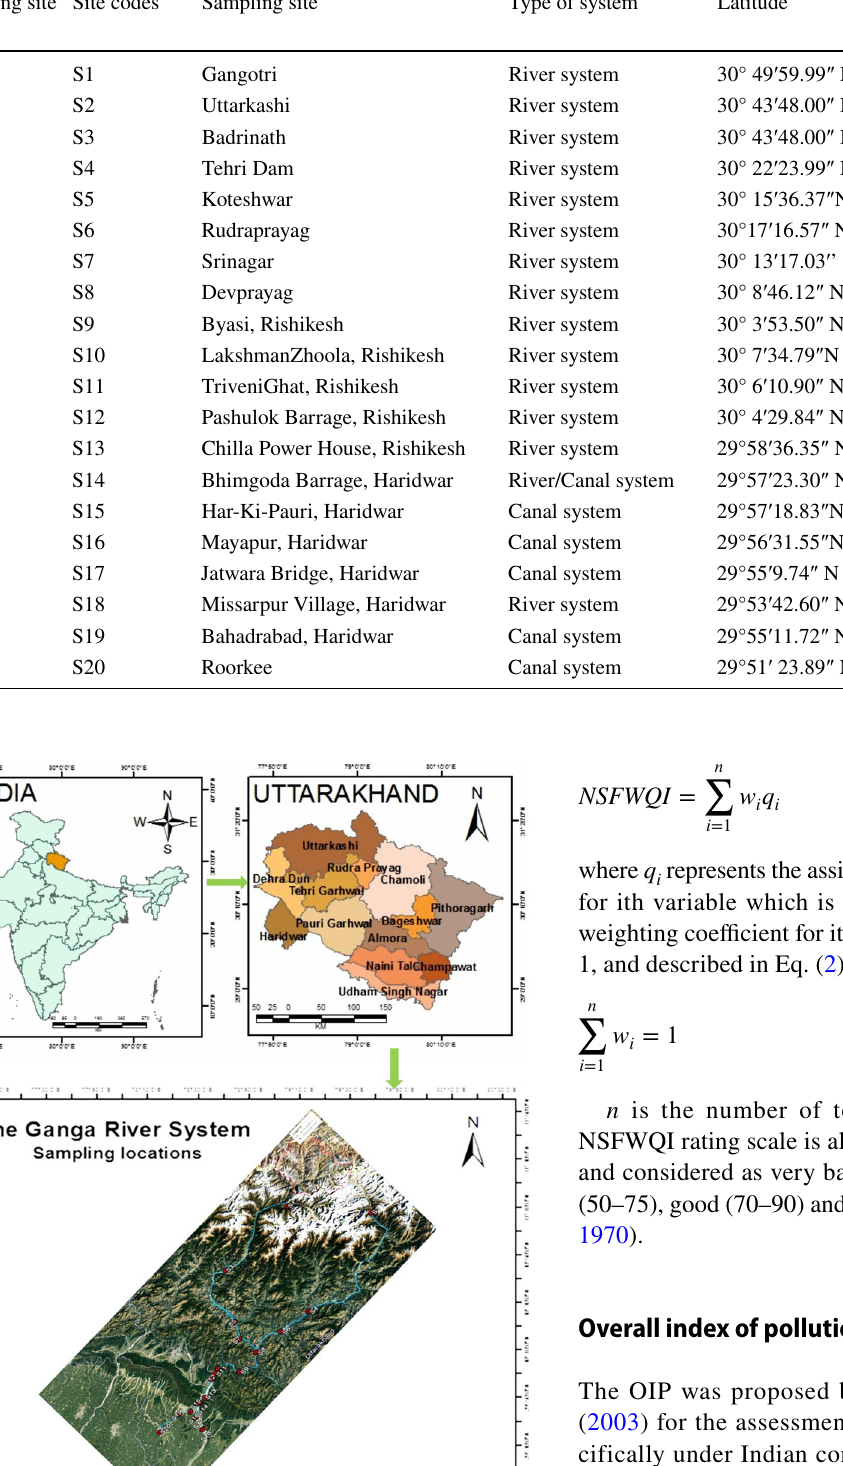
Table 1 Description of Sampling Sites with their geo-coordinates Sampling site no.(m)